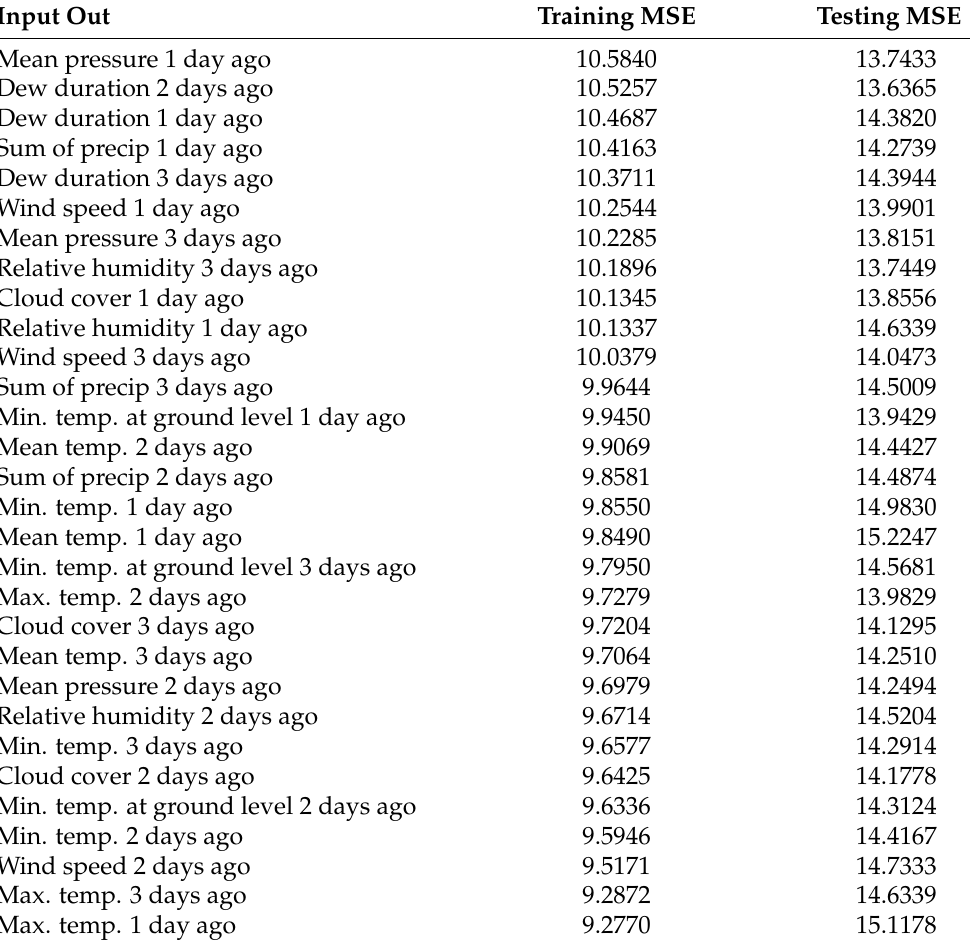
Table A6. The results of the sensitivity analysis for the prediction of the daily sum of